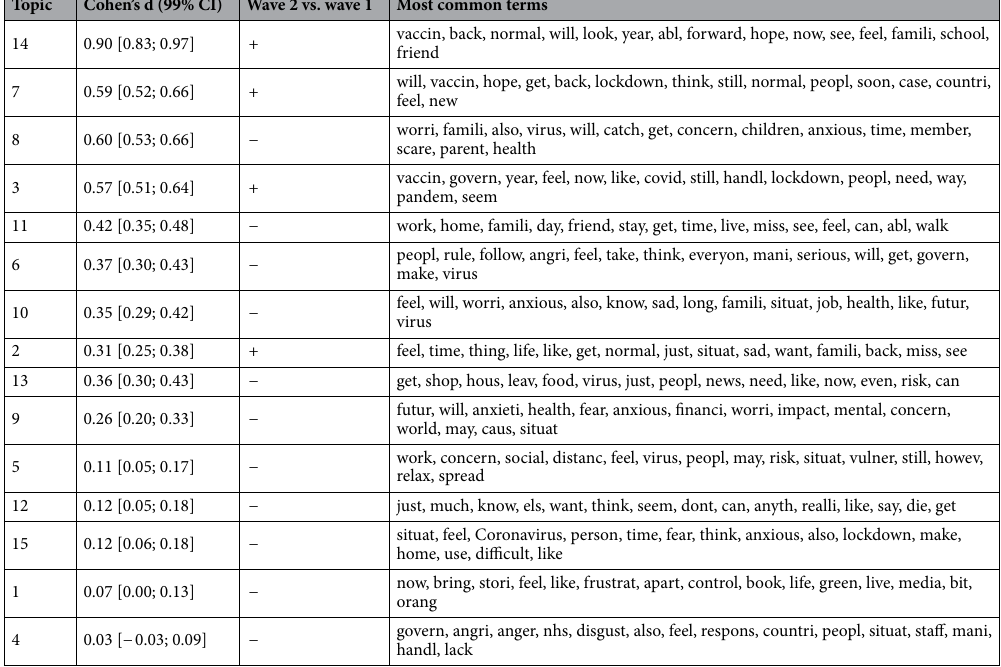
Table 7. Topic terms and differences between phases (long texts). All p < 0.001 except topics 1 and 4.